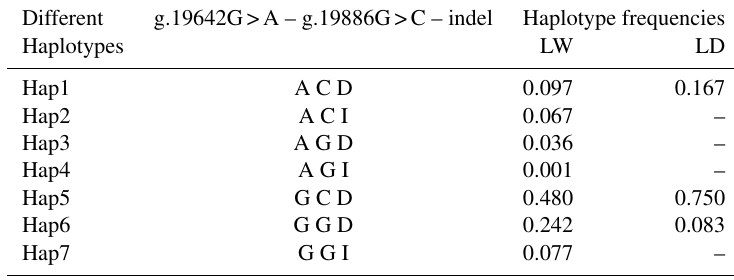
Table 3. Haplotype frequencies within the SPEF2 gene in pig breeds. Different